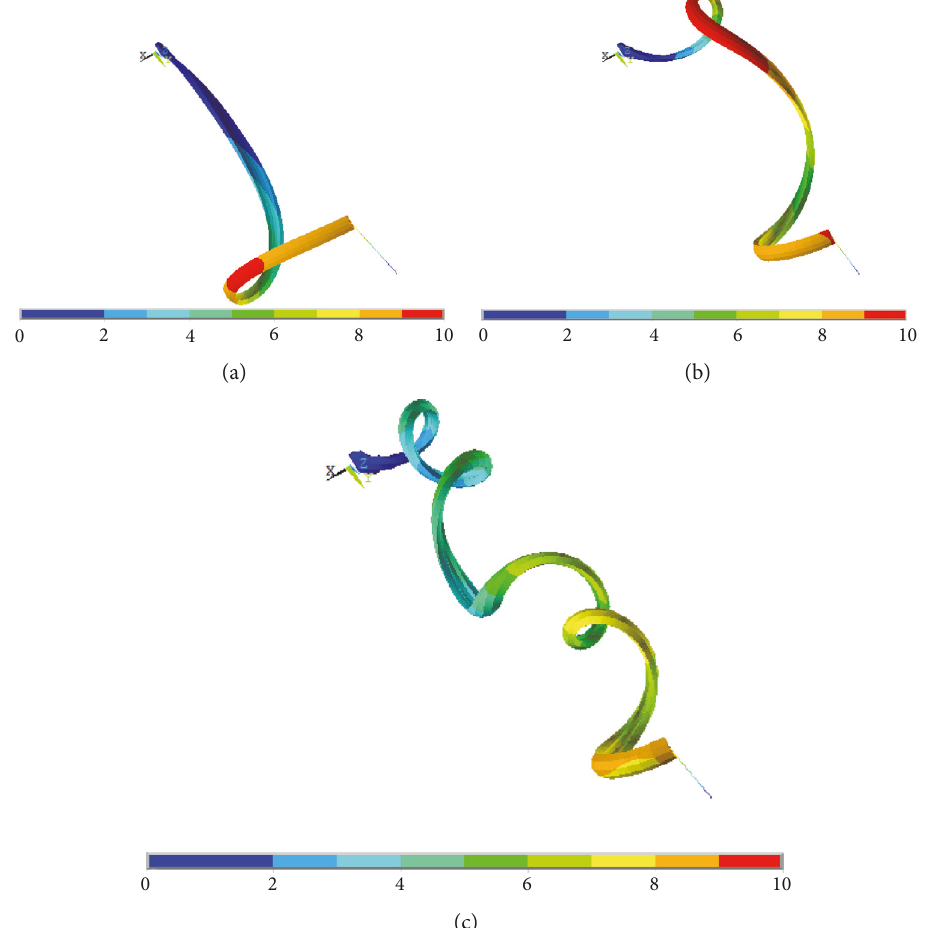
Figure 4: Free coiling of the G-cell model, exemplifying total displacement plots: at (a) 32%, (b) 52%, and (c) the fi nal stage of the analysis. The underlying color bar indicates the overall displacement, in mm, ranging from blue to red as the movement of the section increases.